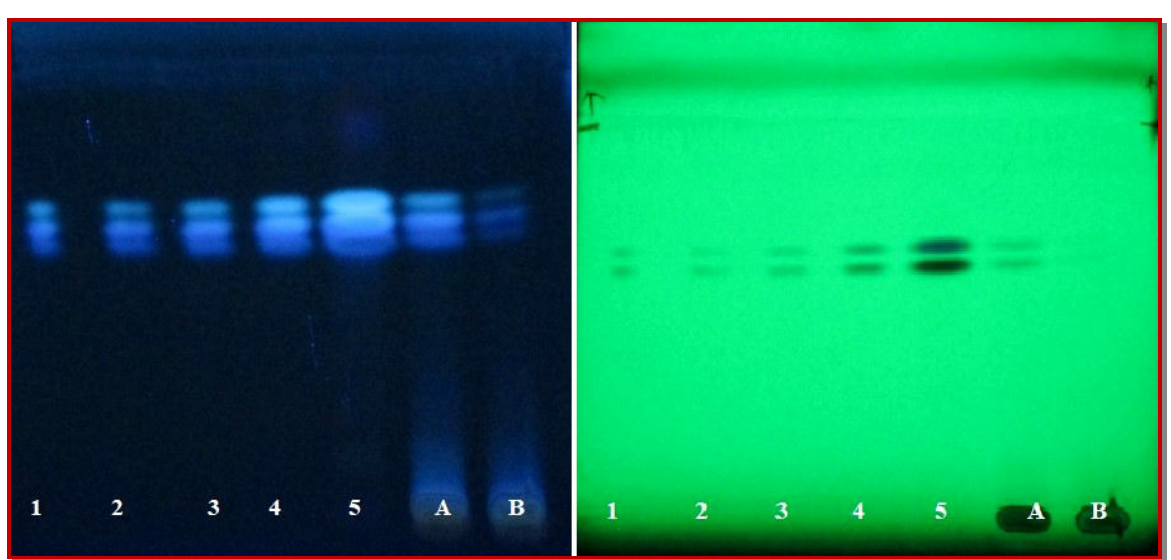
Figure 4: A developed HPTLC plate seen under 366 and 254 nm UV light. Lanes 1 and 5 contain the mixture of standards caffeic acid and coumaric acid at various concentrations ranging from 5 to 10 µg. Lanes A and B contains the hot water extract and soni- cated + extract of Solanum lycopersicum